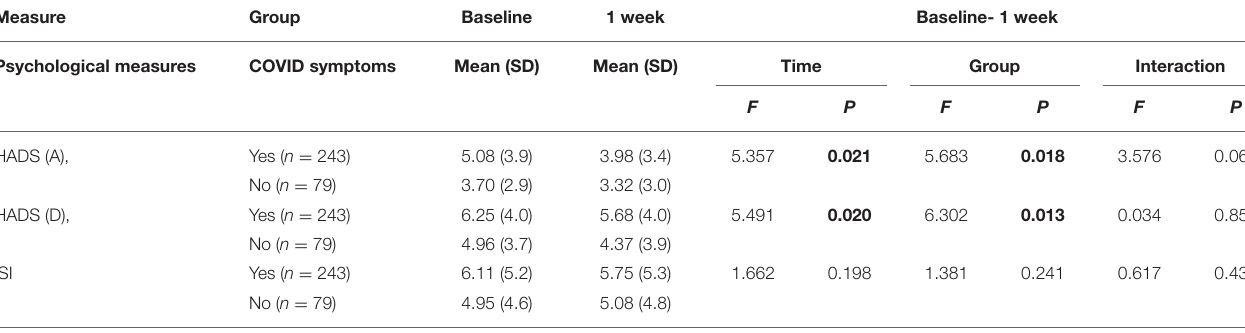
TABLE 4 | Associations of COVID-19 symptoms and psychological symptoms at 1 week. Measure